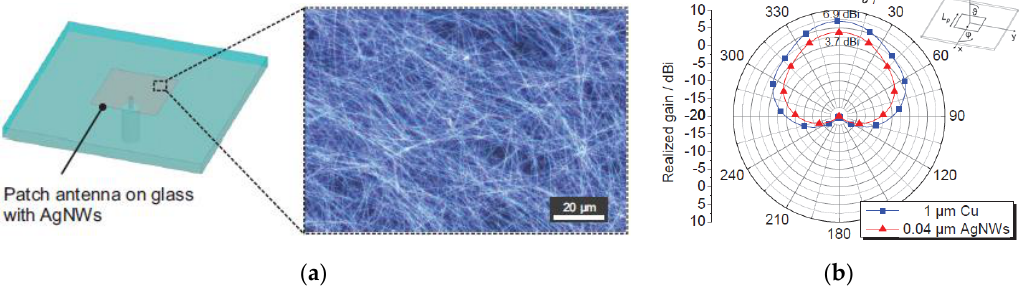
Figure 7. ( a ) Model of the investigated patch antenna and microscopic image of a single silver nanowire (AgNW) coating with 67.9% optical transmission at 550 nm; ( b ) simulation radiation pattern of the patch antenna operating at 61 GHz [27]. (With permission from IEEE) In Reference [28], AgNW patch antennas resonating at 2 GHz for strain sensors are designed. AgNW is embedded in polydimethylsiloxane (PDMS). The final structure features a thickness of 3 mm and an R s of below 5 Ω/sq. The AgNW patch antenna’s resonant frequency changes with the force applied on it. In Reference [29], a AgNW resonating at 3 GHz patch antenna and a 6 GHz two-element patch array are devised. Similarly, AgNW is embedded in PDMS, which features a relative permittivity of 2.67 to 3 and a loss tangent of 0.01 to 0.05. The conductivity of AgNW is approximately 8.13 × 10 4 S/cm, and it can be considered as 8.13 × 10 4 S/cm assuming that the applied strains are relatively small. The radiation efficiency and bandwidth ( S 11 < −10 dB) of the single antenna and antenna array are 41.83% / 88 MHz and 48.8%/ 330 MHz, respectively. The radiation efficiency deterioration is mainly caused by PDMS rather than AgNW.